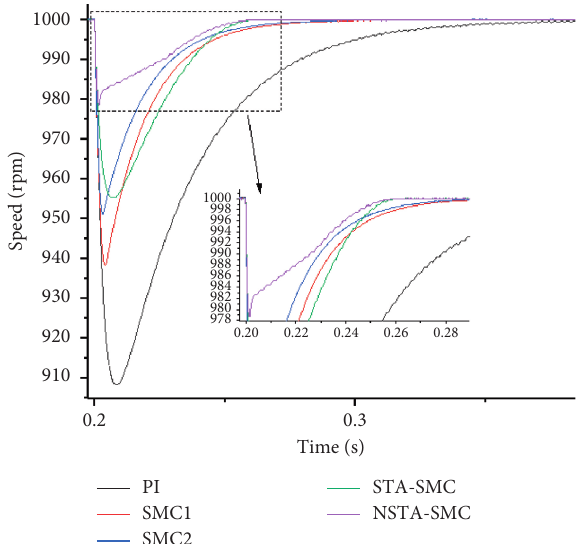
Figure 6: Enlargement of local speed (d).